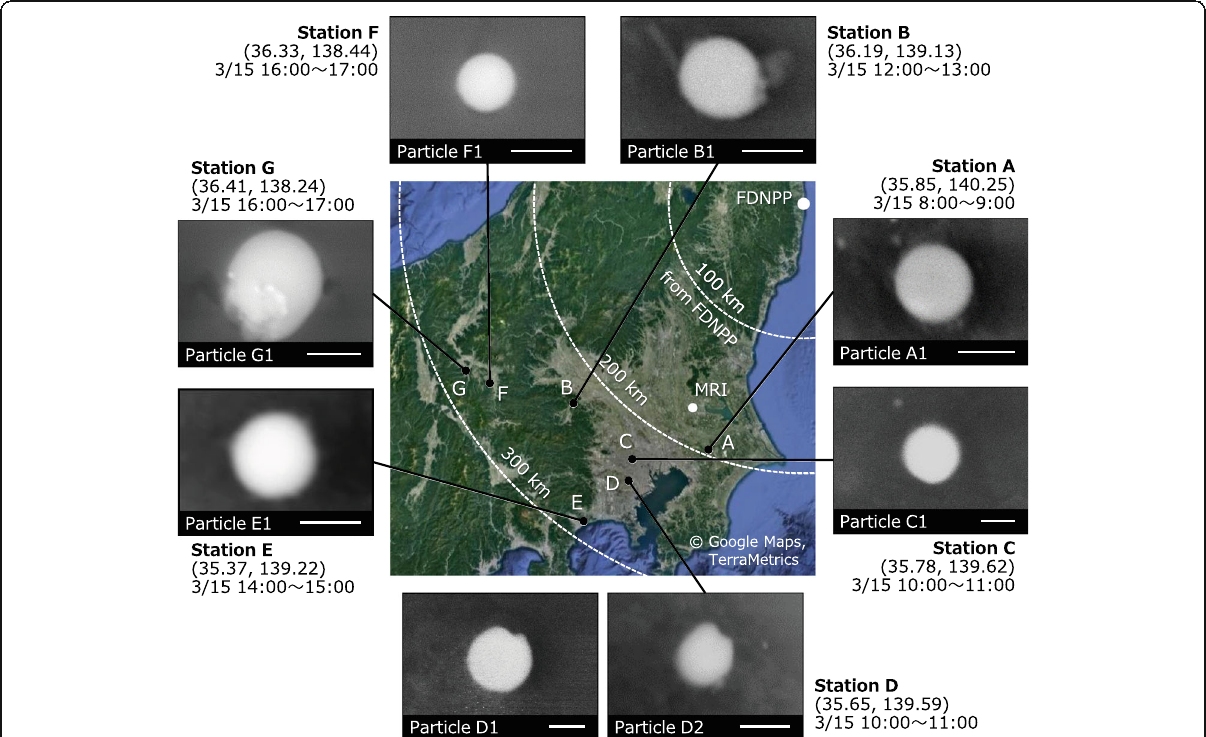
Fig. 1 Locations of monitoring stations A~G in the greater Kanto Region and radioactive particles isolated in this study. Coordinates and collection time of the filters are shown for each station. White dashed lines on the map indicate distance from the FDNPP. Eight CsMPs were isolated from these seven filters as displayed by SEM images around the map. They are nearly spherical in shape with a diameter of 1.3 μ